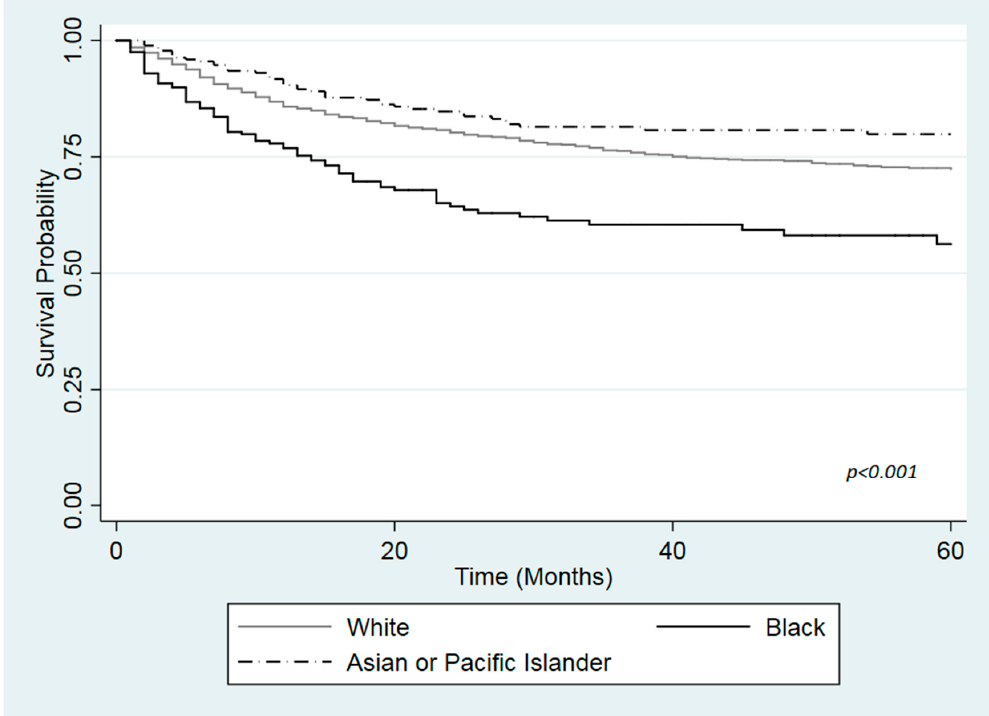
Figure 2. Kaplan-Meier curve for cause specific survival by race among Medicaid patients with urinary bladder cancer, based on the SEER cohort, 2007–2015.